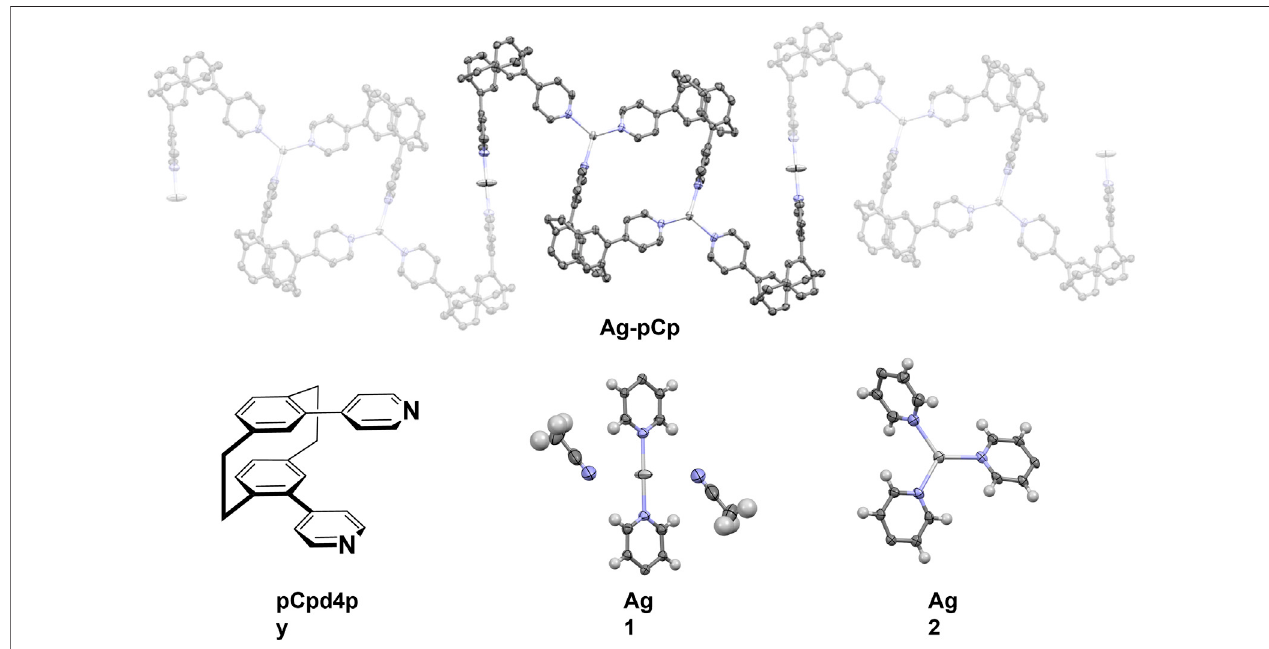
FIGURE 1 | (Top) Representation of the X-ray crystal structure of Ag-pCp, hydrogen atoms, solvent molecules and anions are omitted for clarity. (Bottom, L-R) Diagram of ligand pCpd4py, two different coordination environments for the silver atoms (thermal ellipsoid plot, 50% probability ellipsoids).